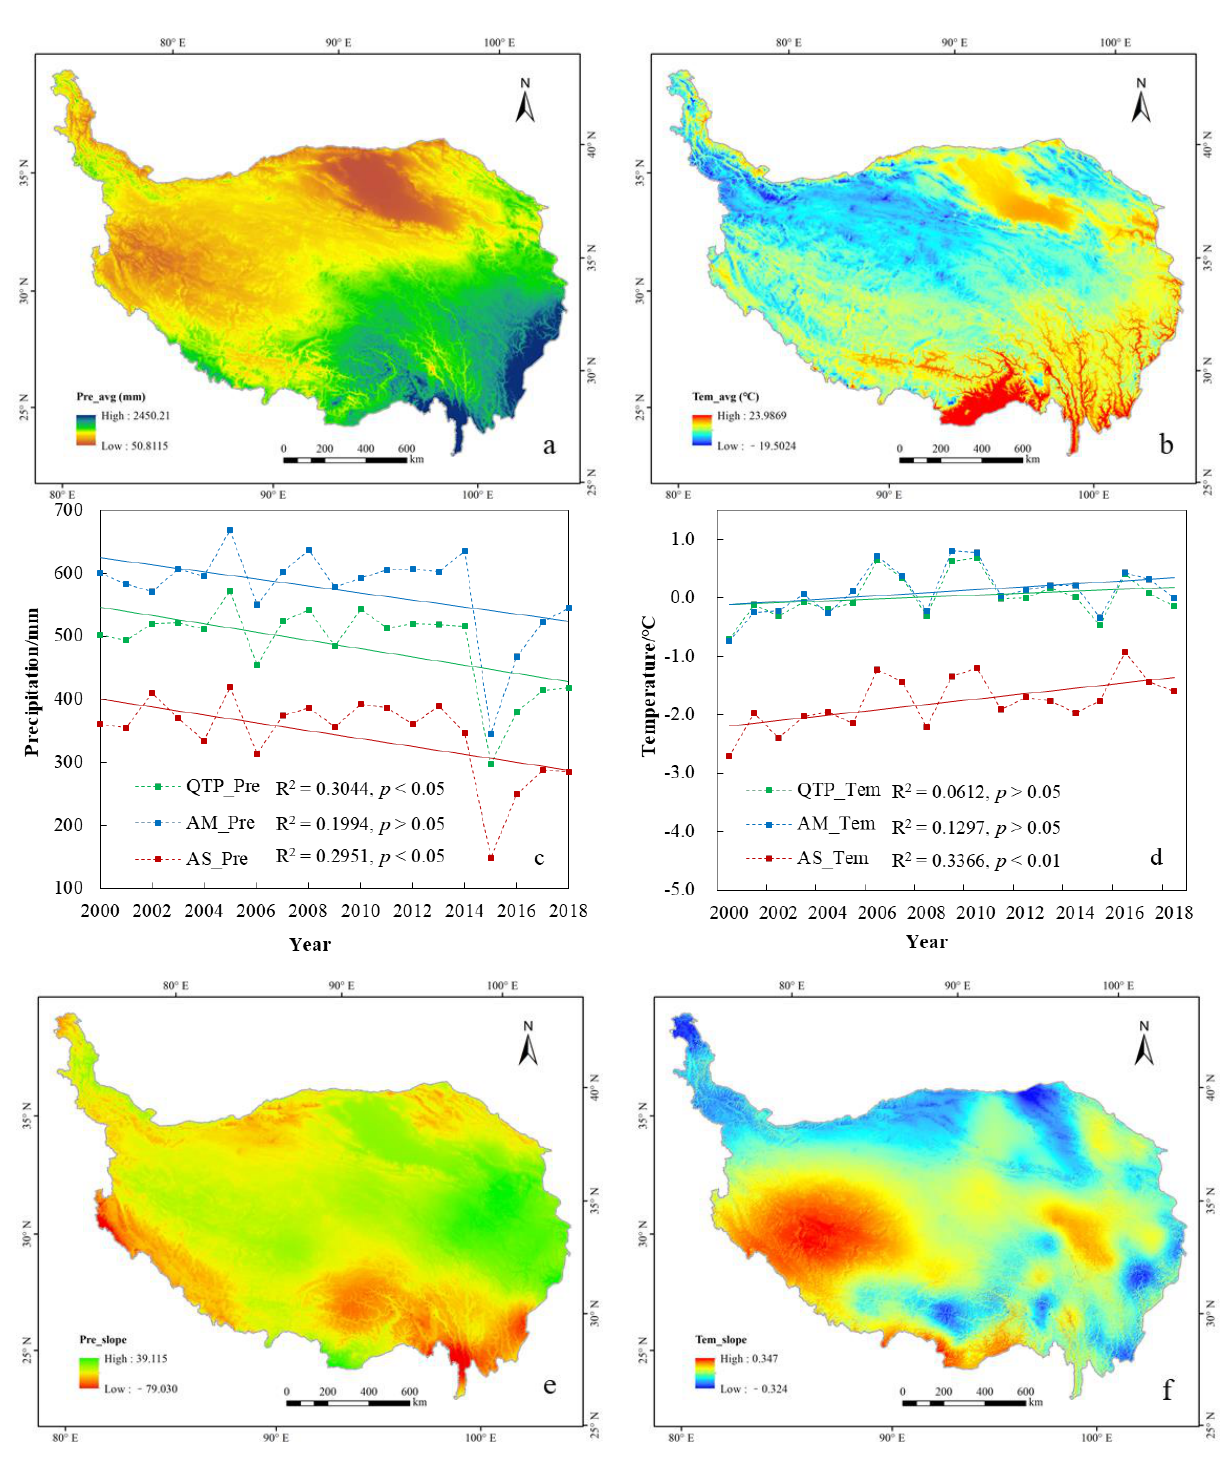
Figure 8. The spatial distribution characteristics of climatic factors and their interannual variation trend from 2000 to 2018: ( a ) Spatial distribution of average annual precipitation over the QTP, ( b ) spatial distribution of average annual mean temperature over the QTP, ( c ) the variation trend in annual precipitation in the QTP, AM and AS from 2000 to 2018, ( d ) the variation trend in annual mean temperature in the QTP, AM and AS from 2000 to 2018, ( e ) slope spatial distribution of annual precipitation in the QTP from 2000 to 2018, and ( f ) slope spatial distribution of annual mean temperature in the QTP from 2000 to 2018.